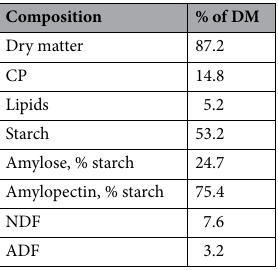
Table 1. Chemical composition of the commercial diet used during trials 1 and 2. DM dry matter, CP crude protein, NDF neutral detergent fiber, ADF acid detergent